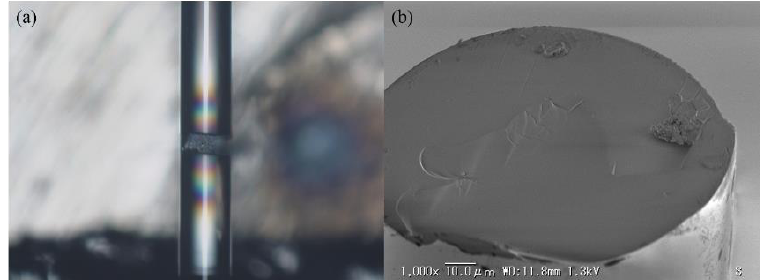
Figure 6. Images of the fabricated micro-cavity. ( a ) a SMF with a micro-cavity. ( b ) the SEM image of the inner surface of the micro-cavity. The machined surface by FIB milling is shown at the upper half of the fiber’s fracture surface.